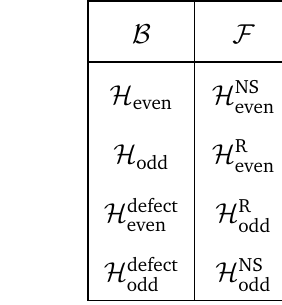
Figure 1: The bosonization / fermionization map and the isomor- phism of Hilbert spaces. Even or odd refers to the charge under ( − 1 ) F or the dual (cid:90) . On the left, defect means the defect Hilbert 2 space quantized with twisted periodic boundary conditions (by (cid:90)